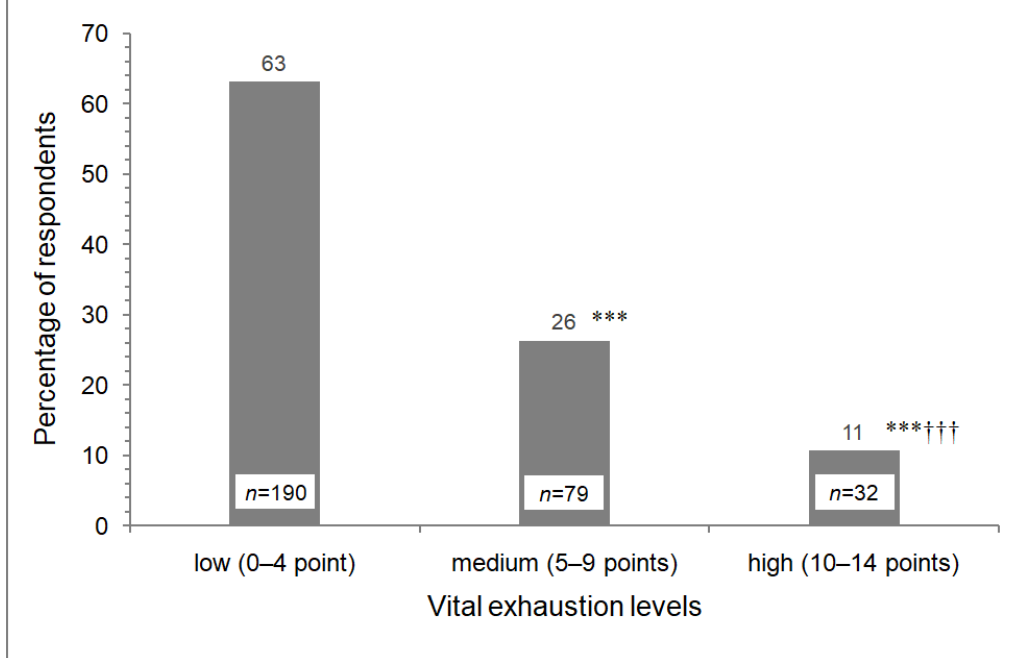
Figure 1. Distribution of male respondents among the vital exhaustion levels (1—low, 2—medium, 3—high) ( N = 301). Unambiguous criteria were chosen to categorize the vital exhaustion. *** p < 0.001 versus level 1; ††† p < 0.001 versus level 2. Paired comparisons are made using Z-criteria with Holm-Bonferroni correction.